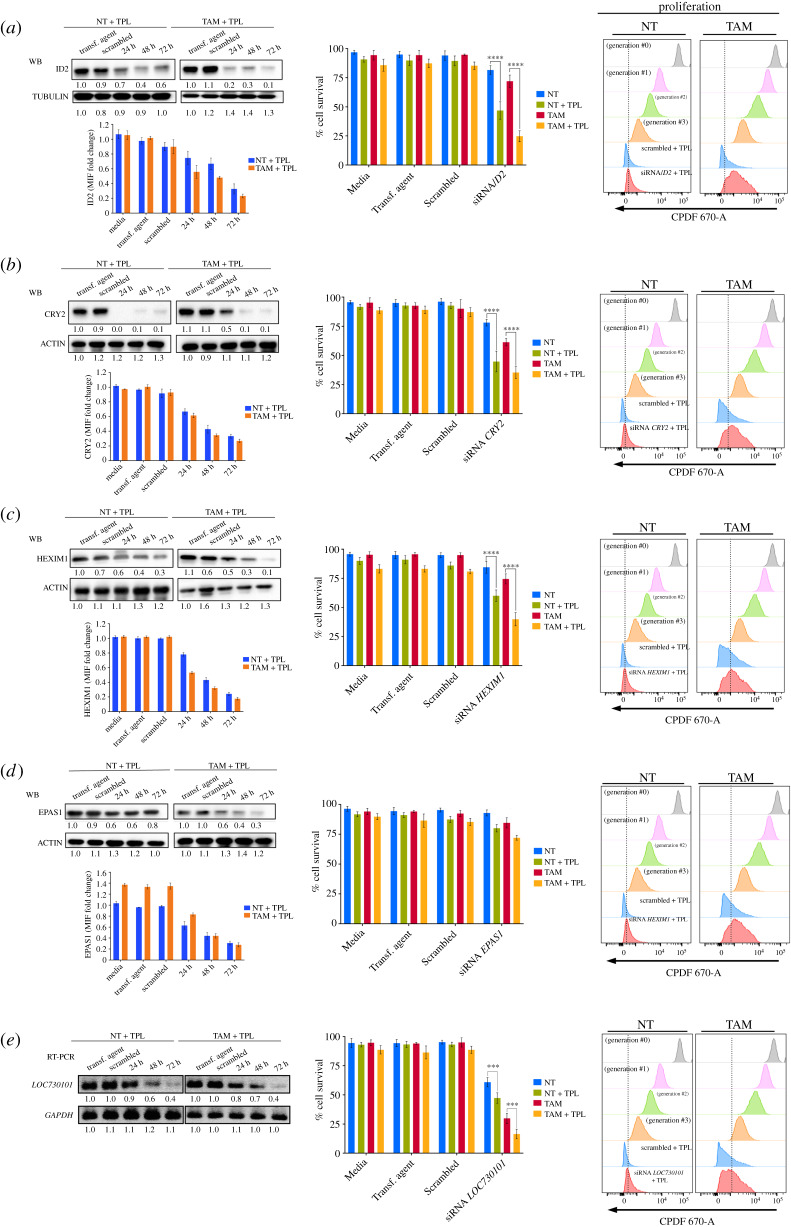
Depletion of transcripts of overexpressed genes by transcriptional stress enhances the sensitivity to TPL. ID2, CRY2, HEXIM1, EPAS1 and LOC730101 were depleted by incubating the corresponding siRNAs at different times. After that, the cells were incubated with 125 nM of TPL for 4 h. The depletion of each protein product was determined by Western blot analysis and by cytometry. In the case of the LOC73101 transcript, its depletion was analysed by RT-PCR. The effect on cell survival and proliferation were also analysed by flow cytometry and the results indicated in the figure. (a) ID2 analysis. (b) CRY2 analysis. (c) HEXIM1 analysis. (d) EPAS analysis. (e) LOC730101 analysis. Cell survival and proliferation only show the effect of TPL after incubation of the corresponding siRNA by 72 h. The name of each gene is indicated in the corresponding panel. Densitometric analyses were performed using actin or GAPDH as a loading control in western blot and RT-PCR, respectively; the relative quantification is indicated under each blot and the data showed as a representative example from three biological replicates. Graphs show mean values ± s.d. (standard deviation). Significant differences were analysed by t-test. Statistical significance is indicated (****p < 0.0001 or ***p < 0.001).